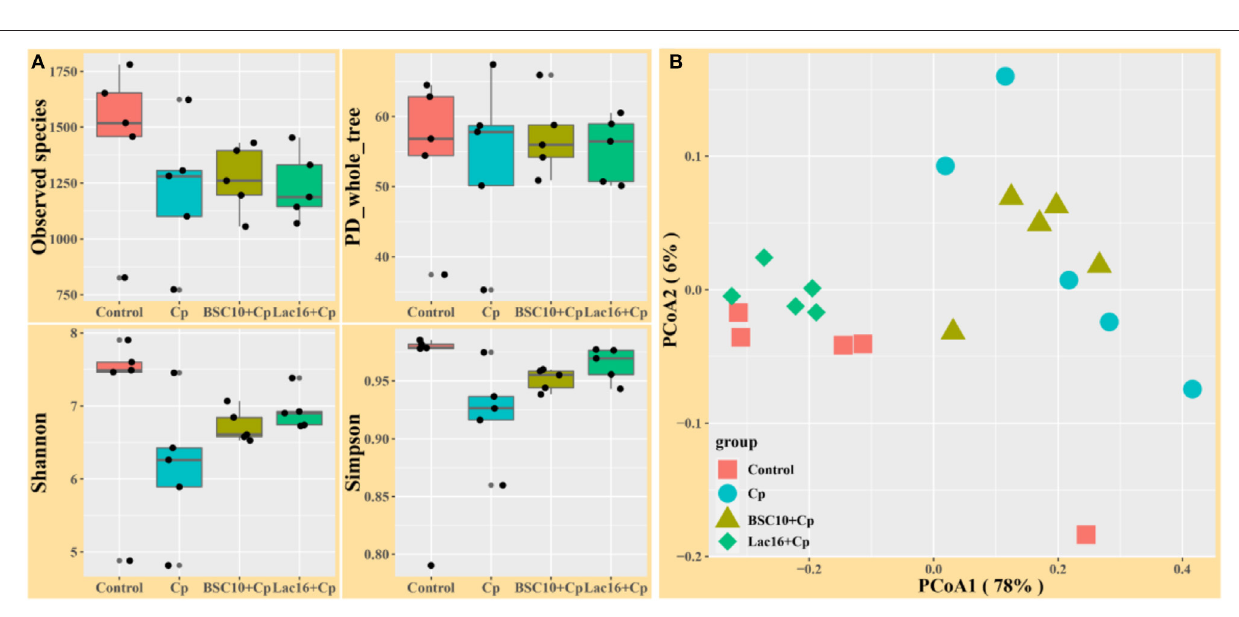
infection. The STAMP and LEfSe analysis based on level 1 and level 3 of the microbial-predicted pathway functions further verified the differences in metabolic functions ( Figures 7 , 8 and Supplementary Figure 2 ). Specifically, L.